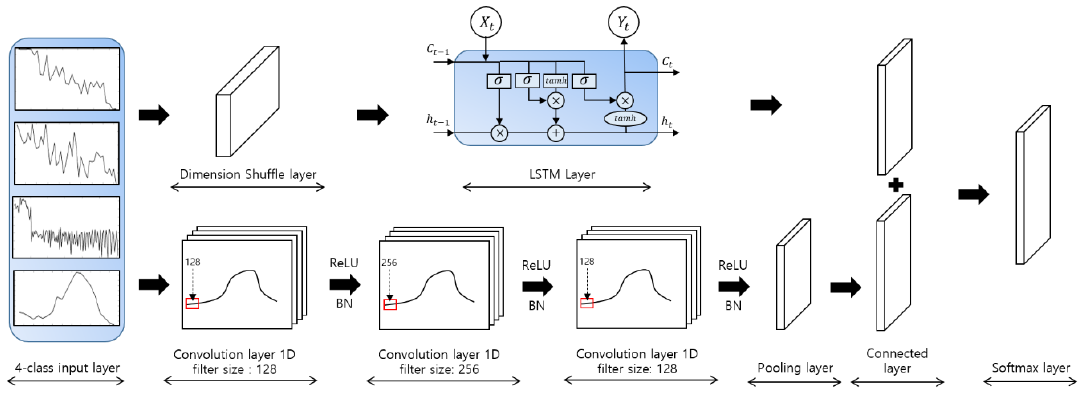
Figure 6. LSTM-FCN model for pet dog sound events classification.